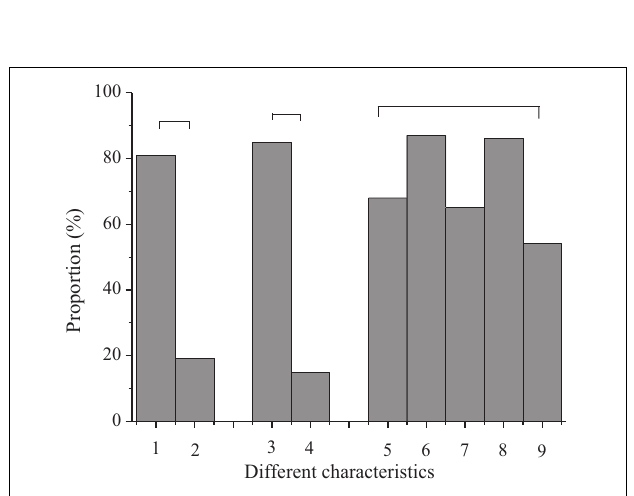
FIGURE 7 | The result of onset detection is based on convolution neural network (CNN) network.